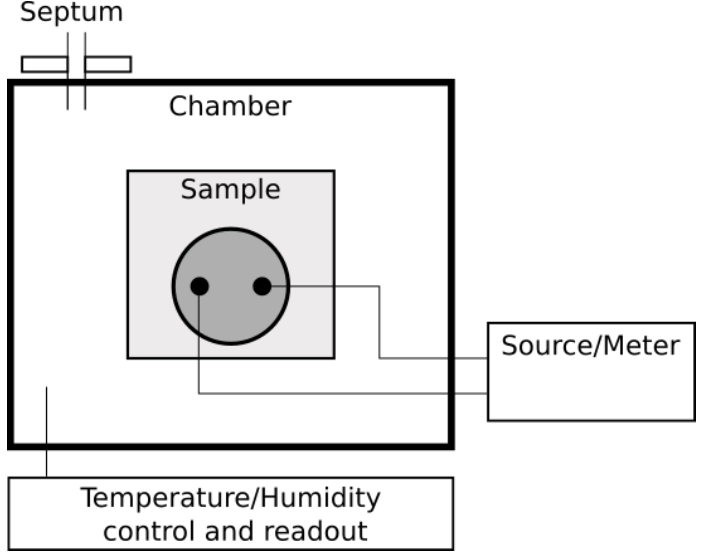
Figure 1. Schematic view of the measurement